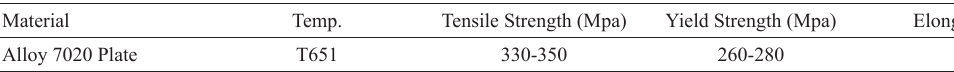
Table 2: Mechanical Properties of Aluminium 7020.